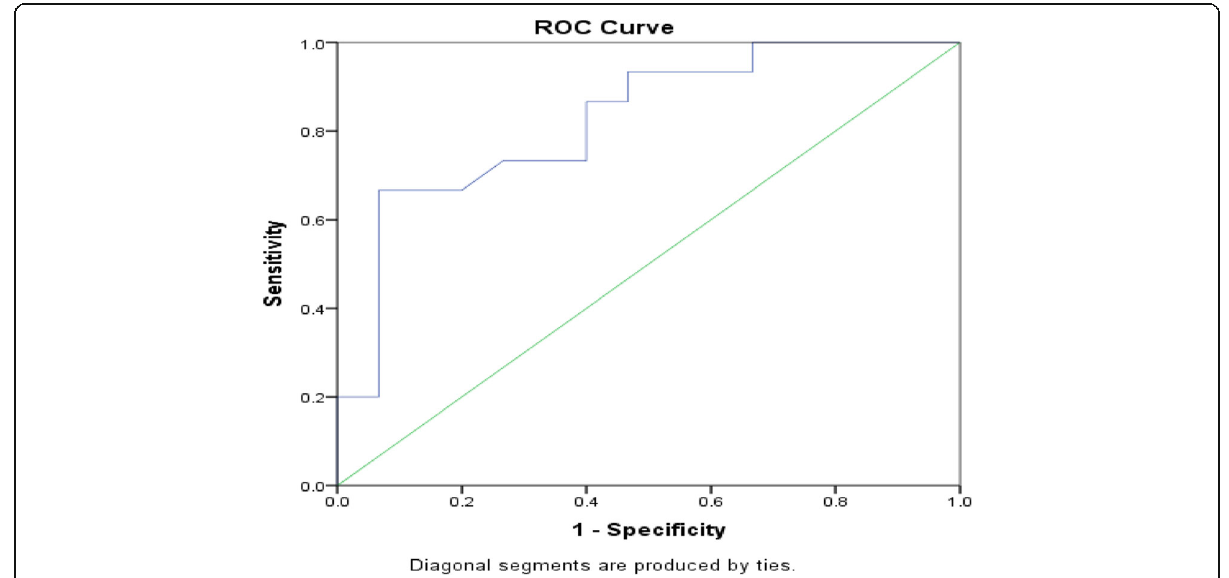
Fig. 7 Receiver operating characteristic curve (ROC) shows that the sensitivity and specificity of the CD47 level in discriminating renal transplant recipients with stable allograft function from renal transplant recipients with chronic allograft dysfunction were 73.3% and 73.3%, respectively, at a cut-off level of 1186 pg/ml (area under the curve = 0.